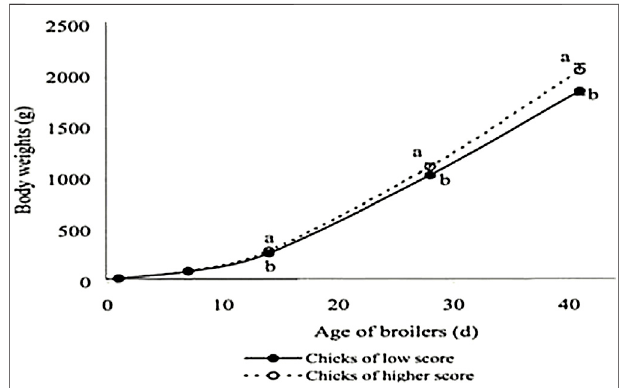
FIGURE 4 | Broiler growth according to day-old chick quality. From Tona et al. (2003a).